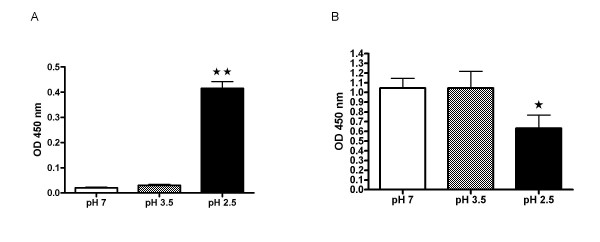
Incubation of sera at pH 3.5 does not induce artifactual ELISA signals nor inactivate authentic anti-Aβ antibody binding in ELISA assay. Sera collected from unvaccinated mice (6A) and mice vaccinated with Aβ 1–42 peptide (6B) were incubated with dissociation buffer at pH 7.0 (open bars), 3.5 (grid bars) or 2.5 (solid bars) for 20 minutes, separated by centrifugation through 10,000 MW filters neutralized and reconstituted to original volume. They were then incubated in a standard ELISA assay using full length Aβ to coat the plate. * P < 0.05 compared to pH 7.0; ** P < 0.001 compared to pH 7.0.